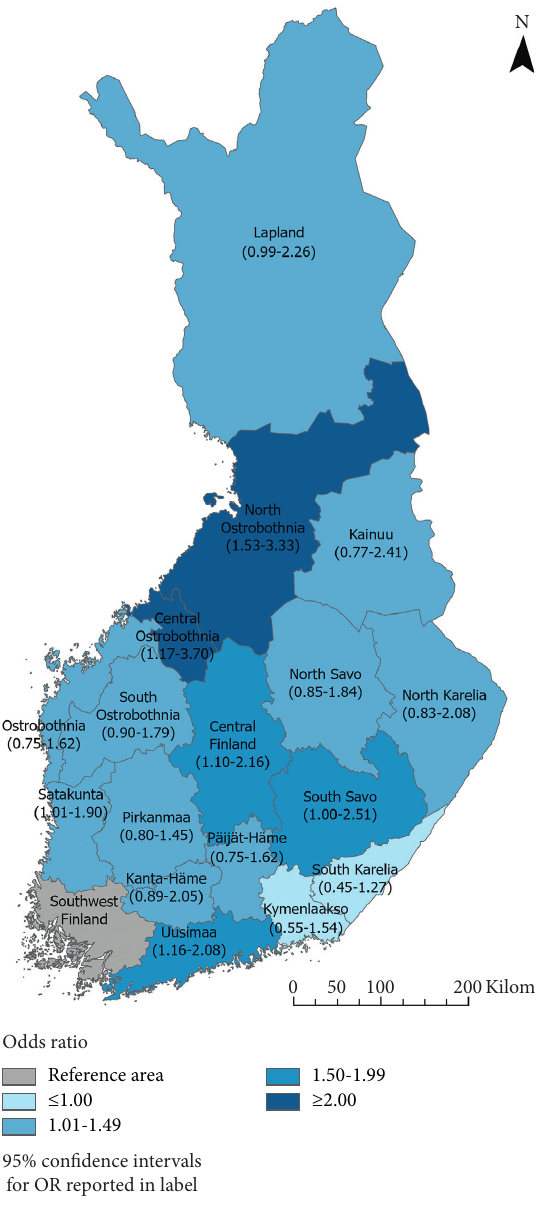
Figure 1: Geomap presenting the association between dental caries experience (DT > 0 vs. DT ≥ 1) and the place of residence among the Finnish